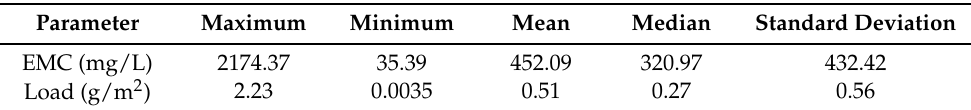
Table 5. Characteristics of TSS EMC and Loads for the monitored